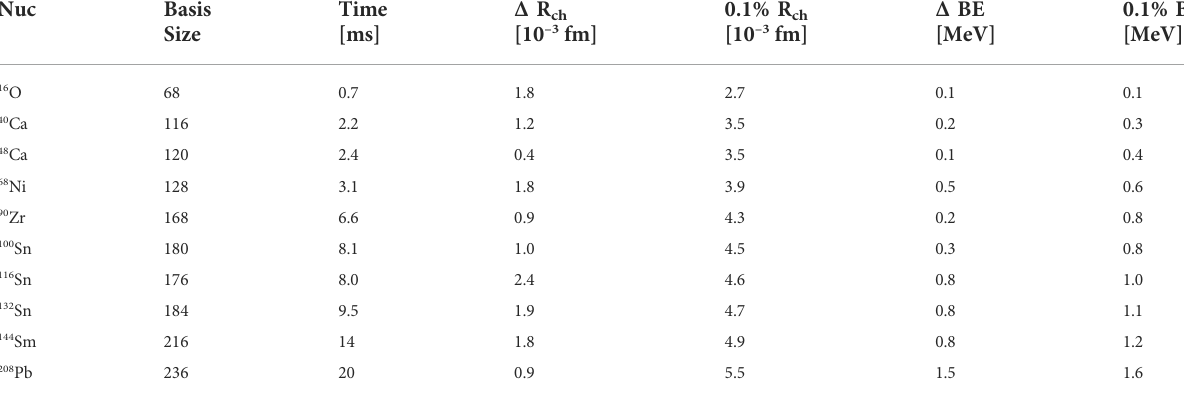
TABLE 1 Results from the basis selection procedure using the 50 samples from the validation set.